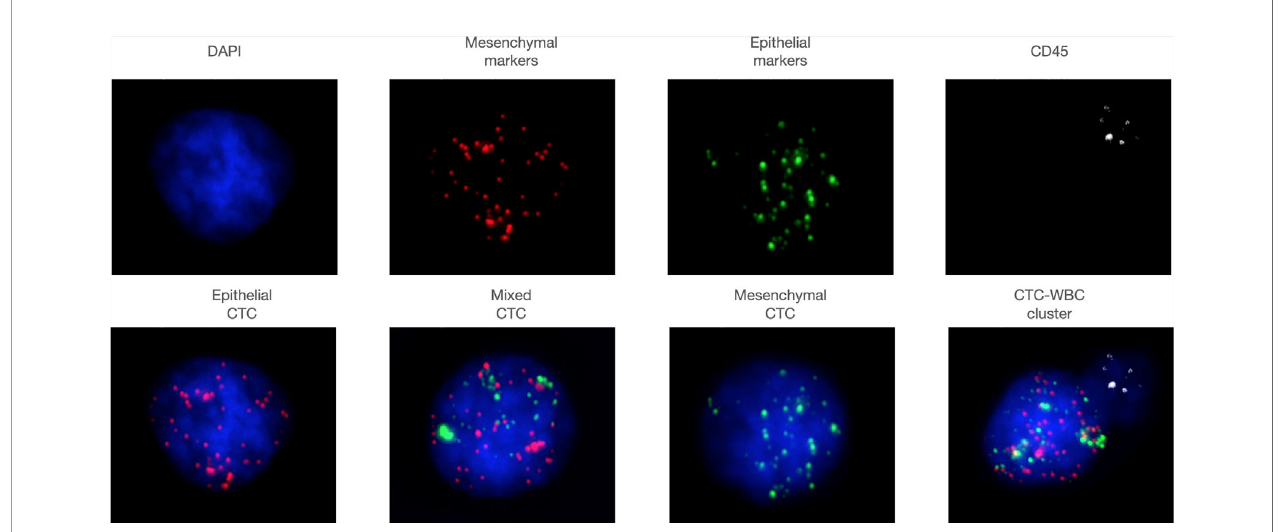
FIGURE 1 | Representative images of various subtypes of CTCs and CTC-WBC clusters. Epithelial cells are positive for EpCAM and CK8/18/19 (red fl uorescence), mesenchymal cells are positive for vimentin/twist (green fl uorescence), and mixed cells show red fl uorescence and green fl uorescence. Nuclei were labeled with 40,6-diamidino- 2-phenylindole (DAPI) (blue fl uorescence). White blood cells were labeled with CD45 (white fl